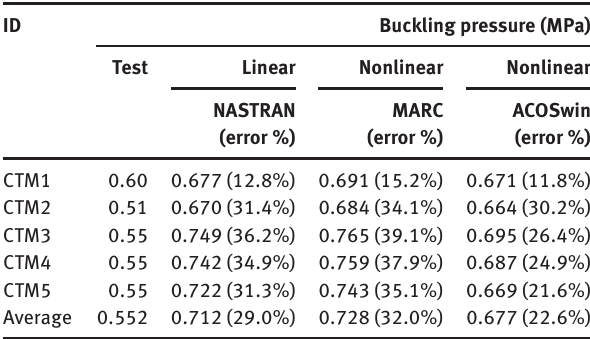
Table 3: Experimental buckling pressure [20].